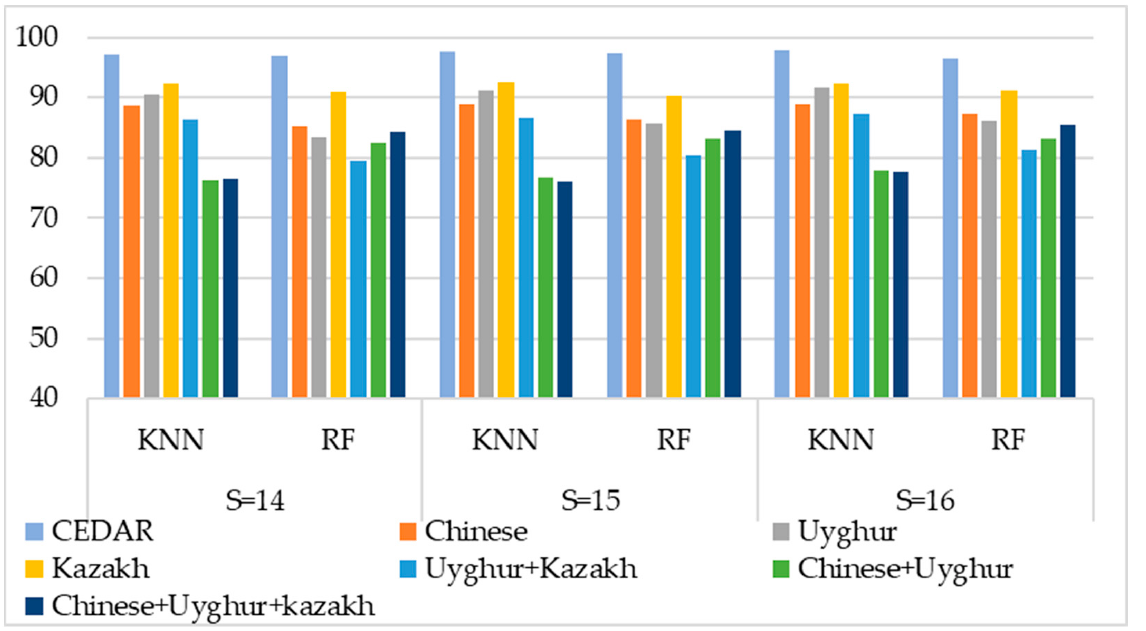
Figure 10. Histogram of recognition results of different values for LOMO feature selection.